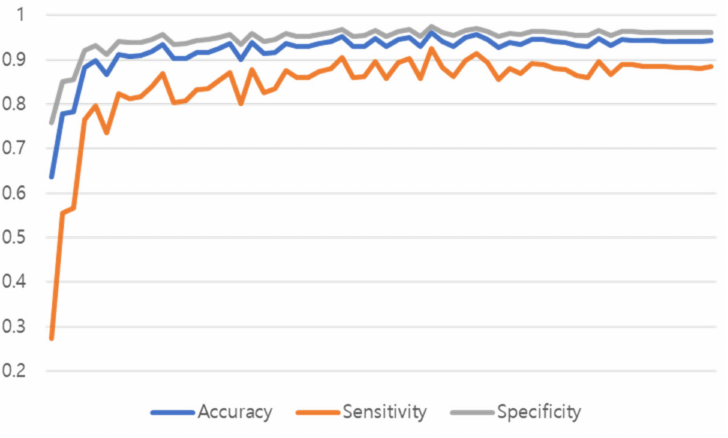
Figure 15. SCH dataset training graph.